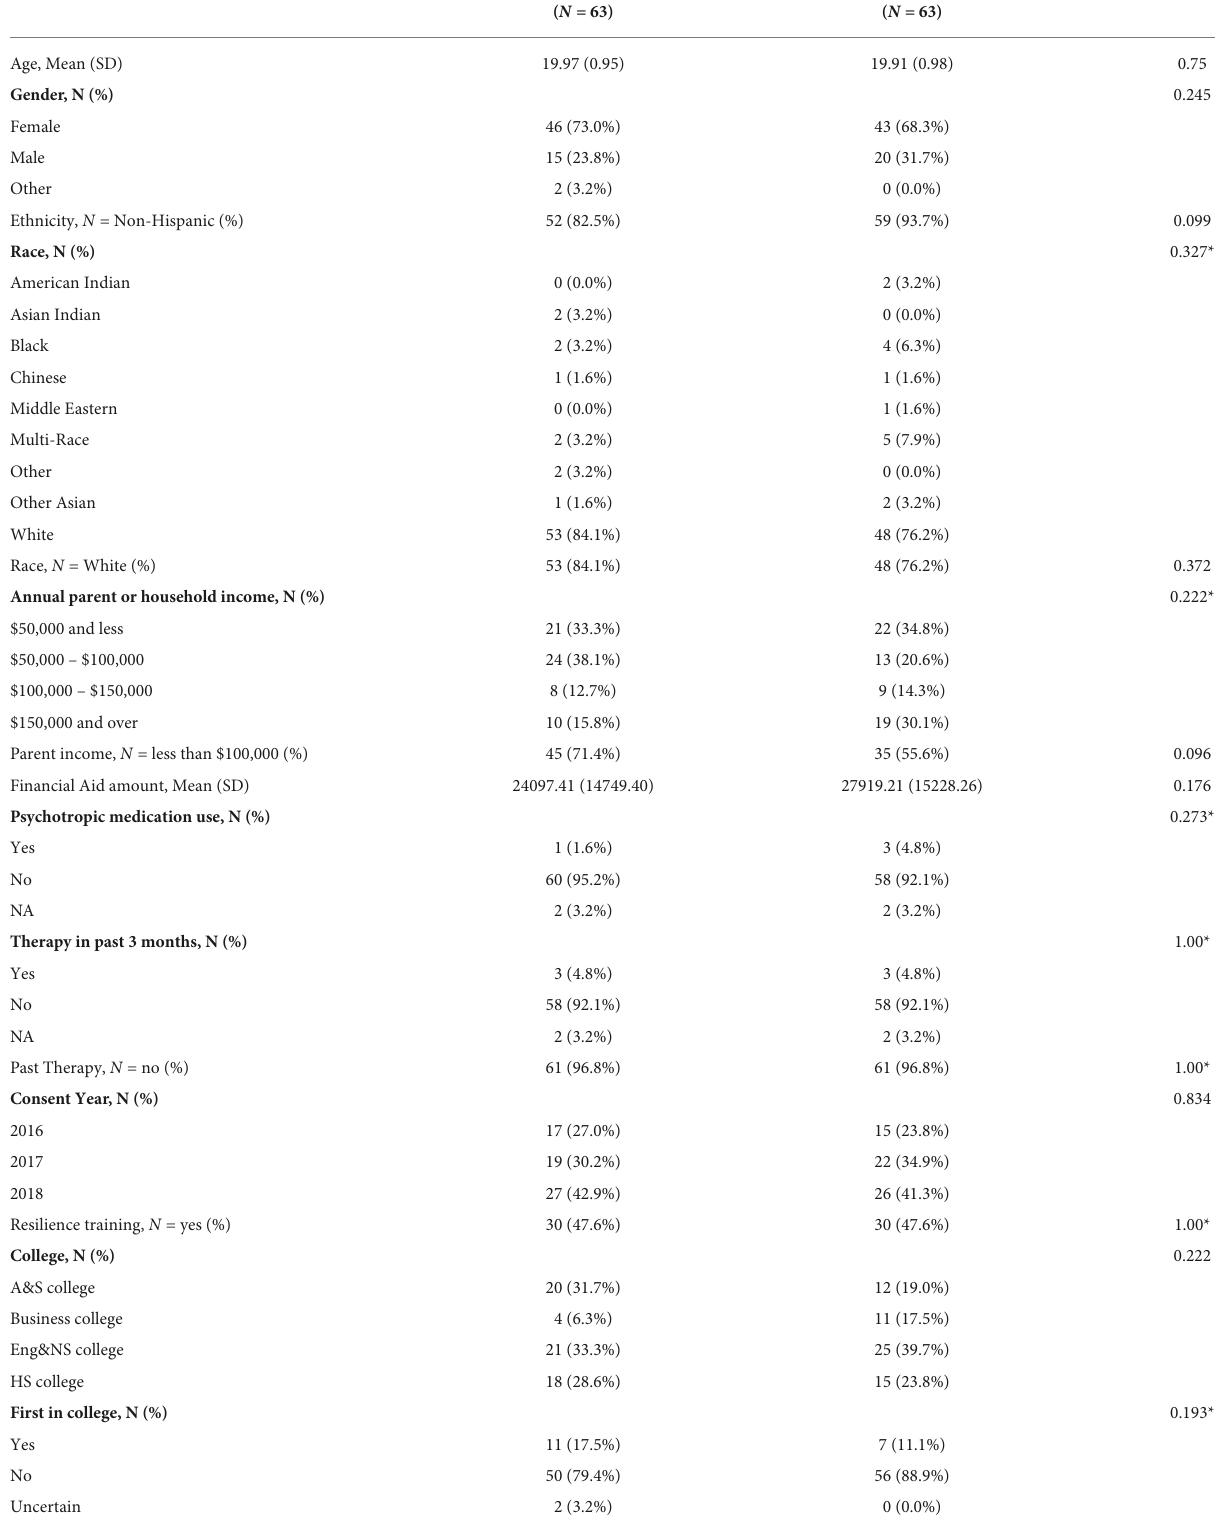
TABLE 3 Overall demographics with matched